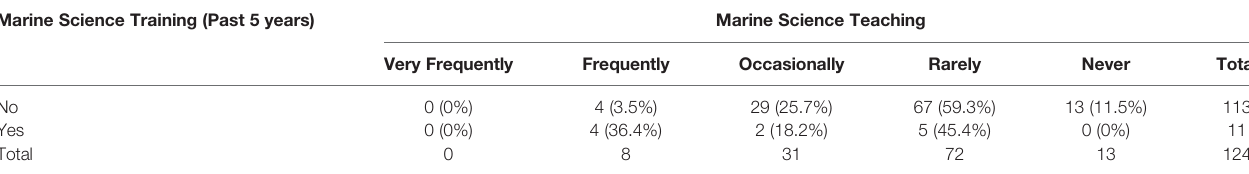
TABLE 2 | Number (percentage) of participants who taught marine science in their classes very frequently (e.g., all, or almost all lessons), frequently (e.g., once, or twice a week), occasionally (once or twice a month), rarely (a few times a year) or never , and whether they had any marine science training in the previous 5 years (Yes/No).